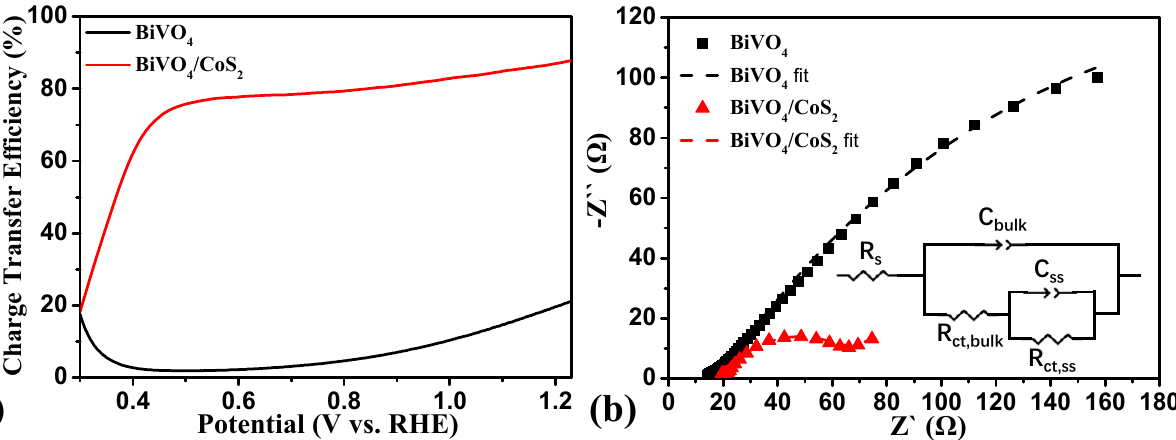
Figure 5. ( a ) Charge transfer efficiencies of BiVO 4 and BiVO 4 /CoS 2 . ( b ) The Nyquist plots of the BiVO 4 and BiVO 4 /CoS 2 photoanodes.